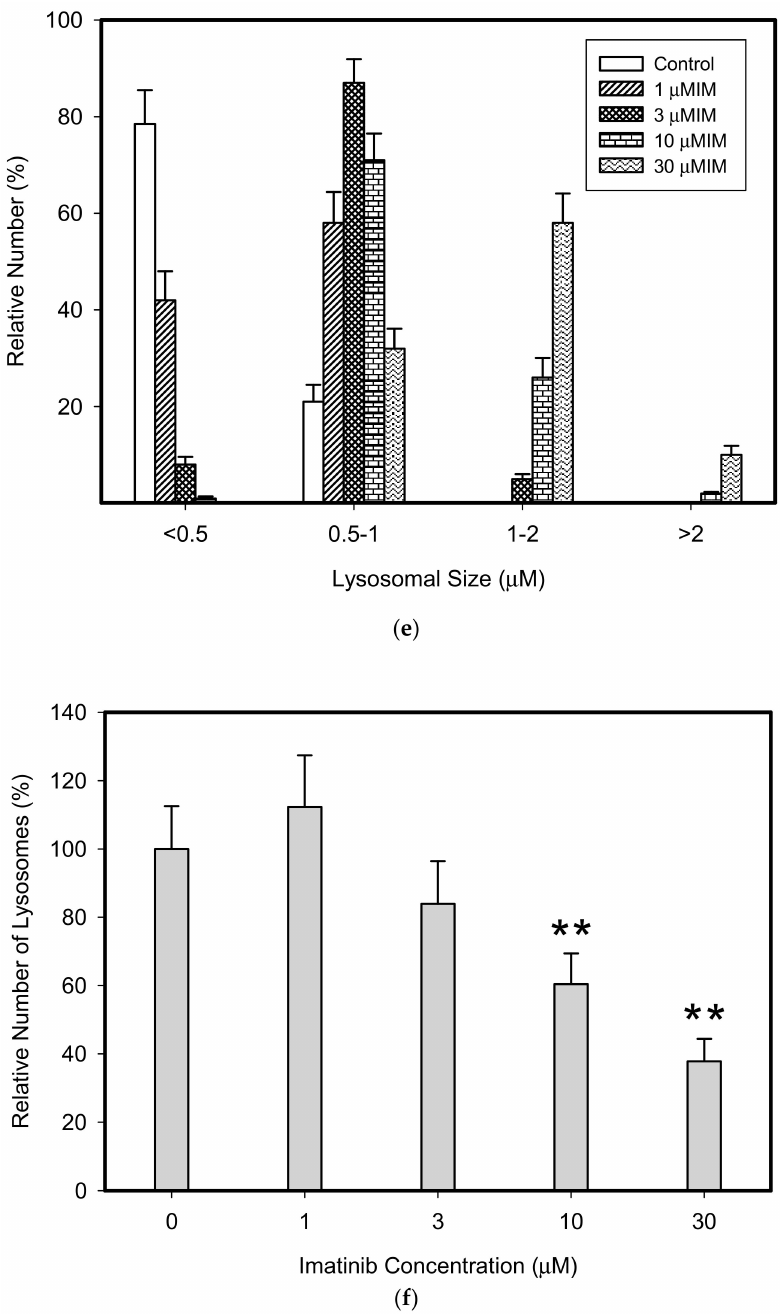
Figure 5. E ff ect of TKIs on lysosomal morphology in K562 cells. Cells were cultured for 6 h in the presence of particular TKI under standard conditions and then fixed in paraformaldehyde and subjected to the immunostaining of LAMP. Cells cultured in medium without TKIs were taken as a control. ( a ) Morphologic changes in lysosomes in IM treated cells (typical analysis). ( b ) Quantitative analysis of lysosomal size in IM treated cells. ( c ) Quantitative analysis of the number of lysosomes in IM treated cells. ( d ) Morphologic changes in lysosomes in GF treated cells (typical analysis). ( e ) Quantitative analysis of lysosomal size in GF treated cells. ( f ) Quantitative analysis of the number of lysosomes in GF treated cells. Lysosomal morphology was evaluated in at least 250 cells for each treatment. The results are represented as means of four independent experiments with standard deviations. ** denotes significant change in the relative number of lysosomes ( p < 0.01) between TKI treated and control